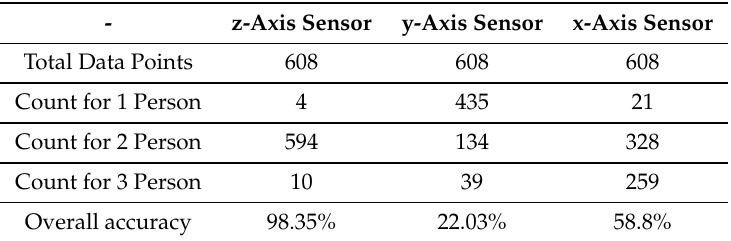
Table 2. Window size: two people